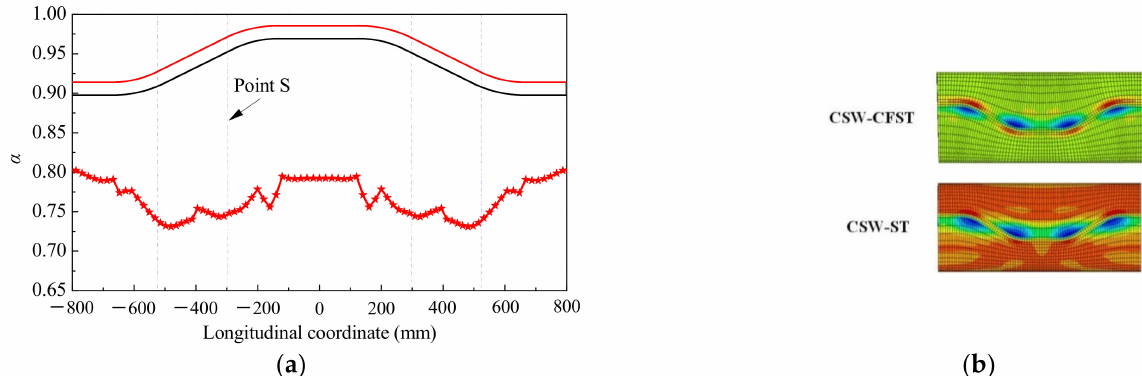
Figure 21. Influence of concrete in chord on hot-spot stress: ( a ) distribution of coefficient α along span length; ( b ) comparison of hot-spot stress